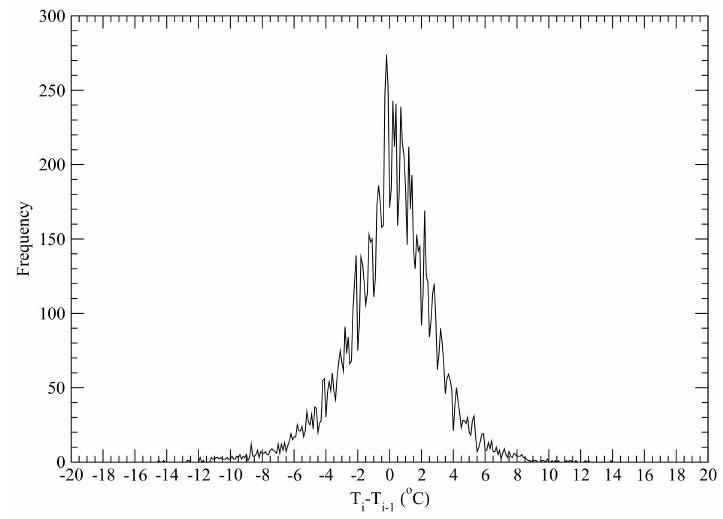
Figure 5. Probability distribution of δ .